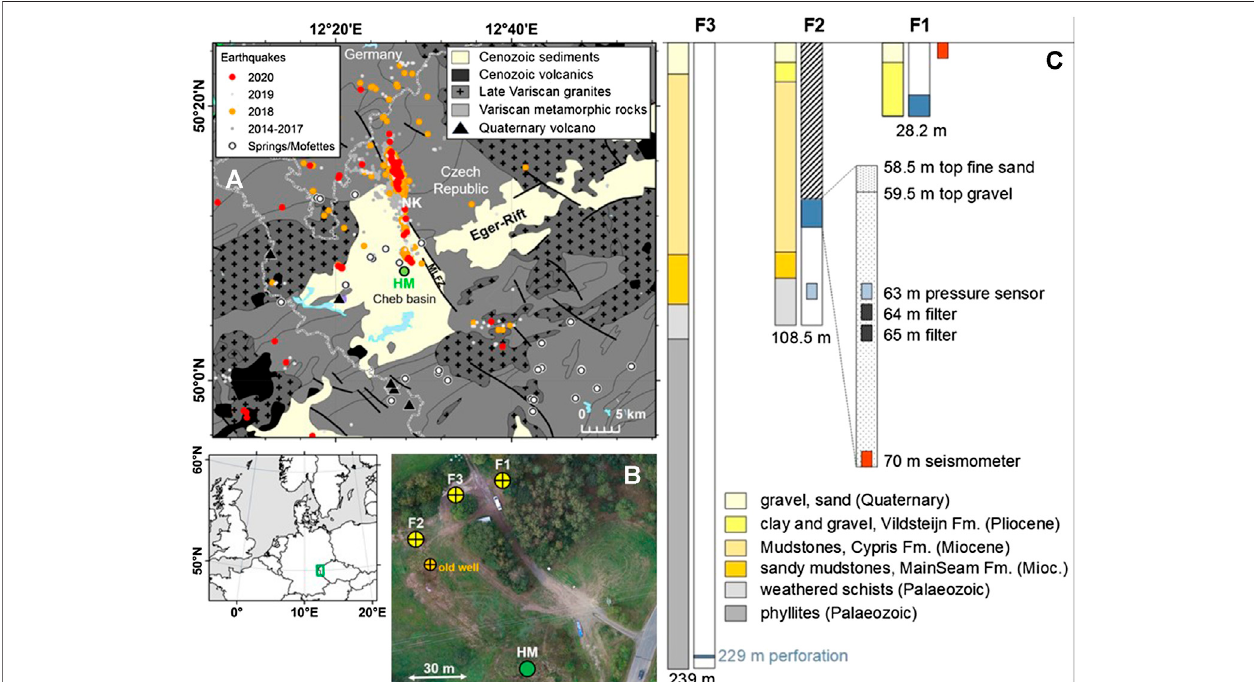
FIGURE1| Technicalset-upofthemulti-levelgasmonitoringsystem. (A) Geologicalmap[simpli fi edfromthe “ GeologicalMapofGermany1:1,000,000(GK1000) ” , BGR]showingthepositionoftheHartou ˇ sovmofette(HM)intheEger-Rift.WhitecirclesmarkmofettesandspringswithCO 2 > 1 g/L.Orangeandreddotsdepictseismic activity during 2018 and 2020, respectively. NK – Nový Kostel focal zone (B) Bird ’ s view of the boreholes and the natural Hartou ˇ sov mofette, (C) simpli fi ed lithological section of boreholes F1, F2, and F3. Sensor con fi guration of F2. Perforated sections of the wells are marked in blue.